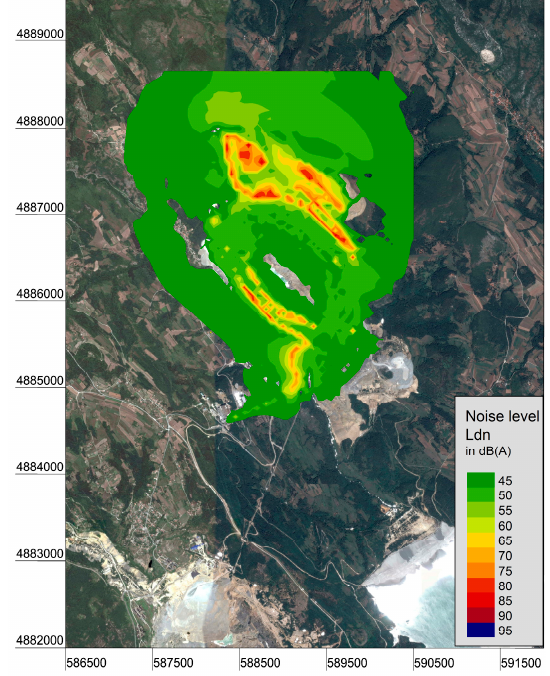
Figure 7. Estimation of noise level around the Veliki Krivelj open pit, Scenario 1.